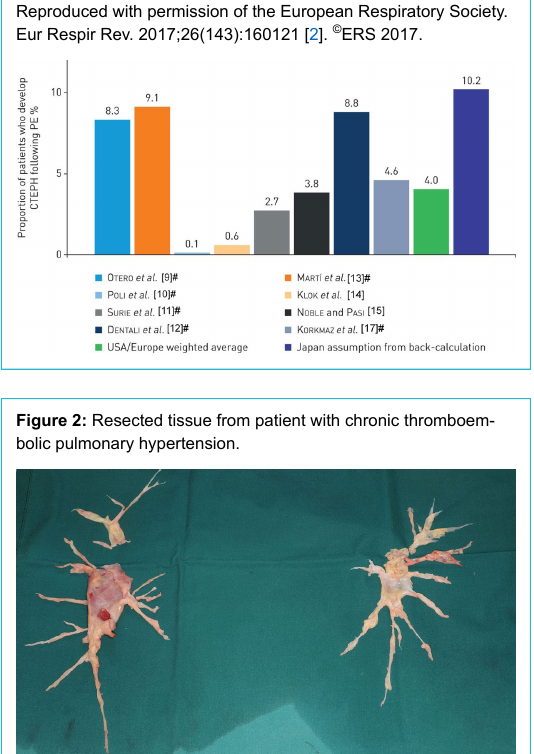
Figure 1: Proportion of patients who develop chronic thromboem- bolic pulmonary hypertension (CTEPH) following pulmonary em-